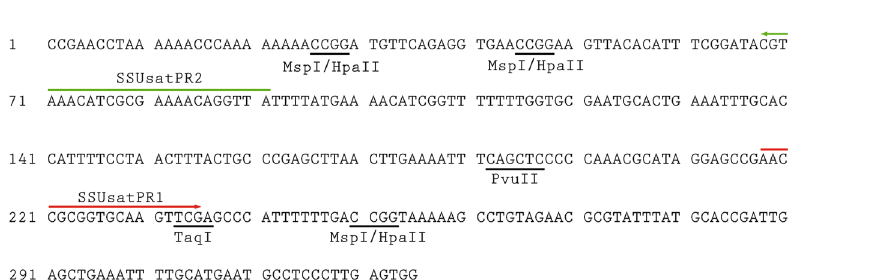
Figure 2. Consensus sequence of the SSUsat monomers from Spisula subtruncata . On the basis of the DNA sequences of the recovered SSUsat monomers from Spisula subtruncata genome, a consensus sequence was derived. Restriction sites for Msp I/ Hpa II, Pvu II and Taq I are underlined. Green and red arrows indicate the positions of PCR primers used for SSUsat amplification in related